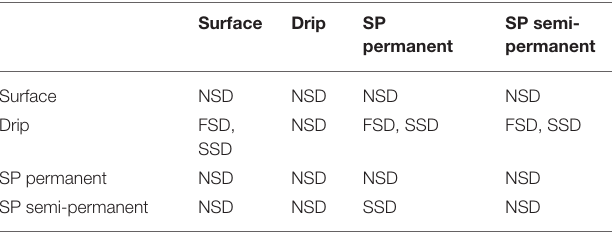
TABLE 4 | First- and second-degree stochastic dominance analysis for barley crops.